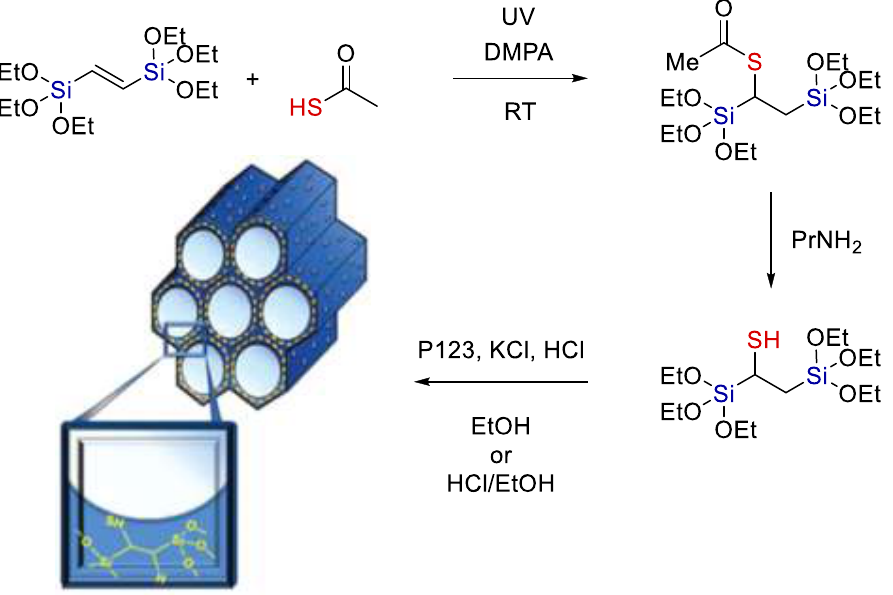
Figure 8. The synthesis of 1-thiol-1,2-bis(triethoxysilyl)ethane (2) and the corresponding thiol – PMO (SH – PMO). Reprinted/adapted with permission from Ref. [35]. (SH–PMO). Adopted from Ref.